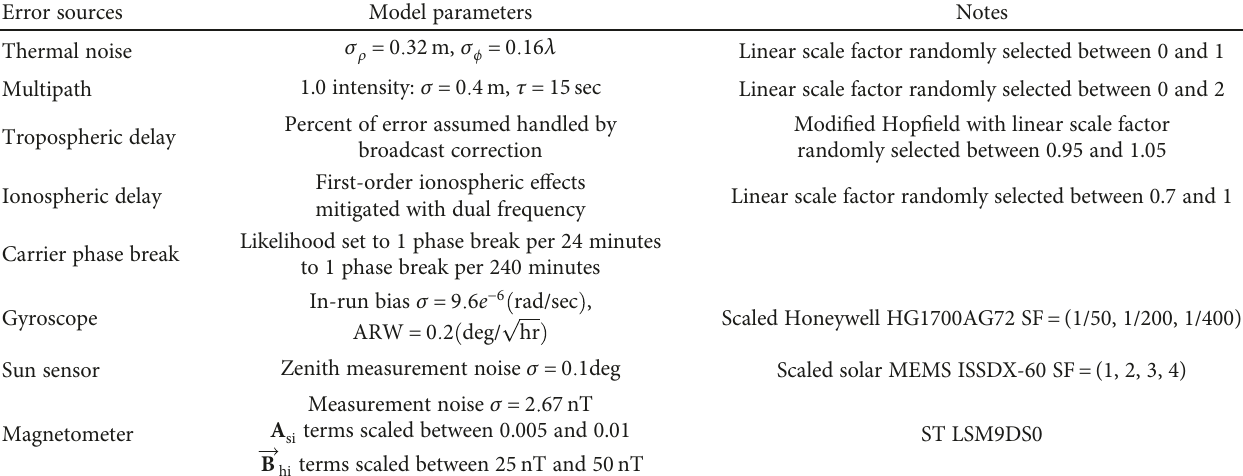
Table 2: Sensor error source Monte Carlo simulation distribution parameters, same as in